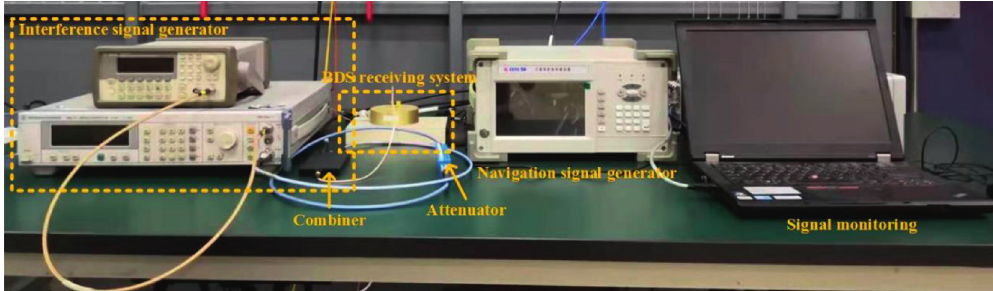
Figure 3: Electromagnetic injection effect experiment platform of the pulse interference.